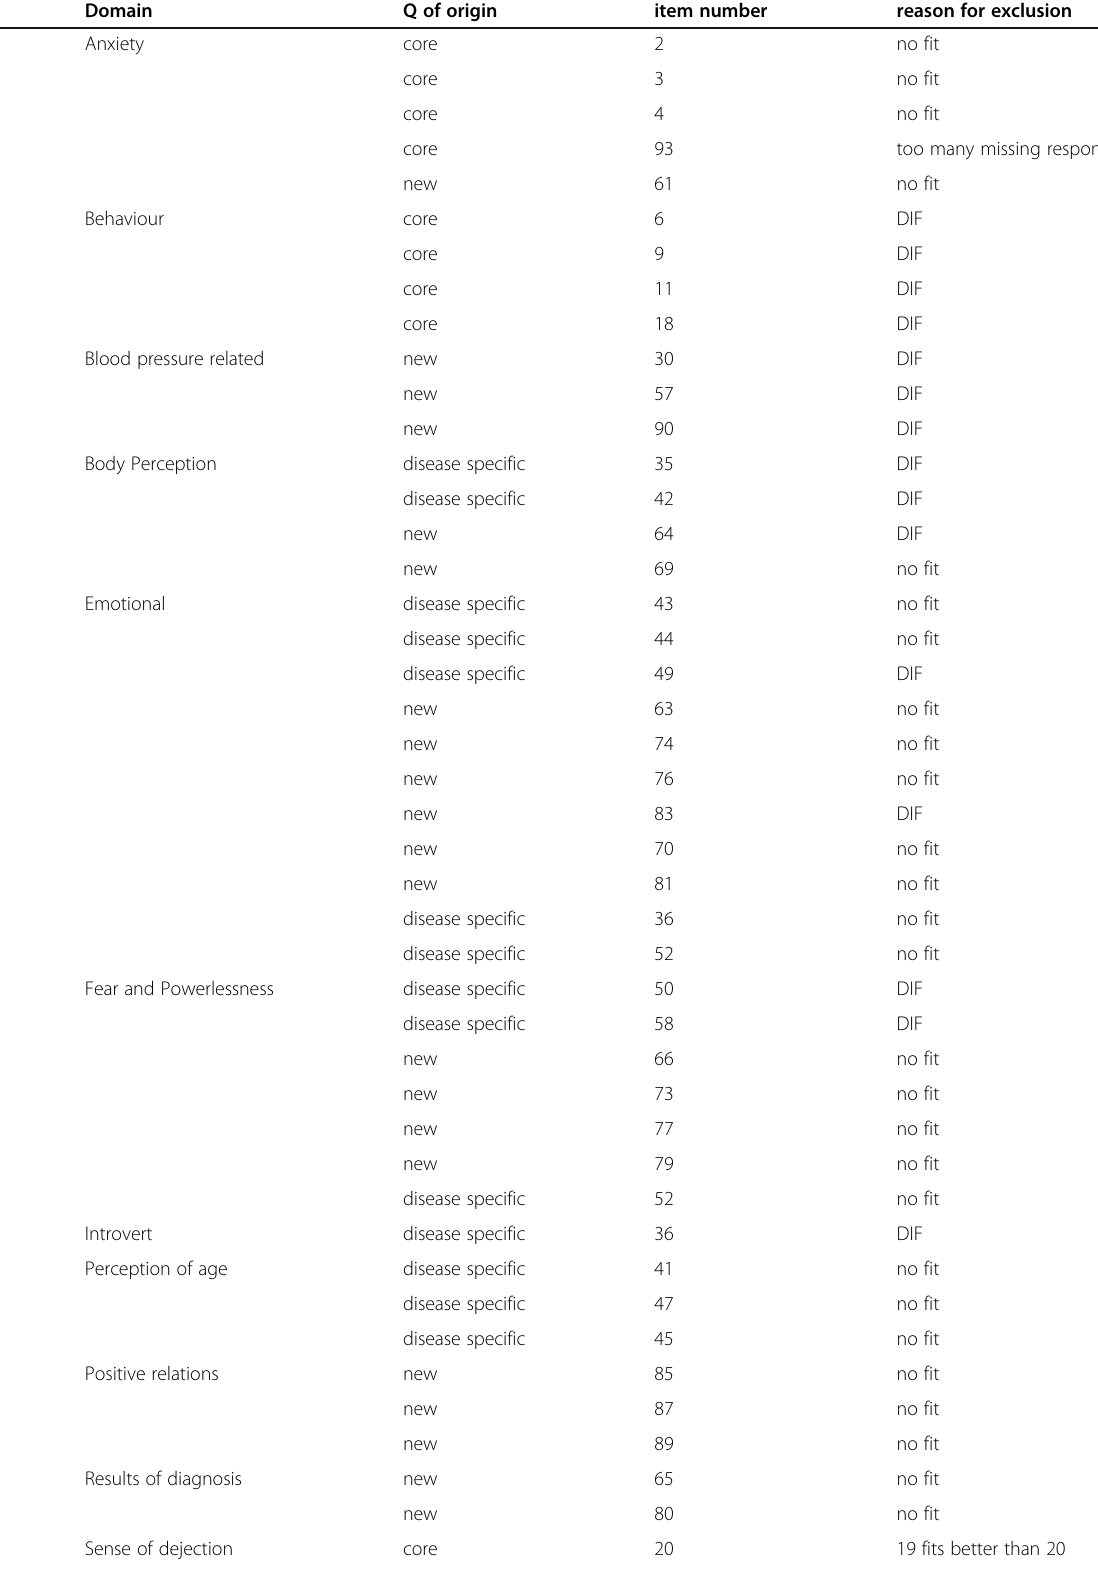
Table 3 Rejected items and reasons for the exclusion